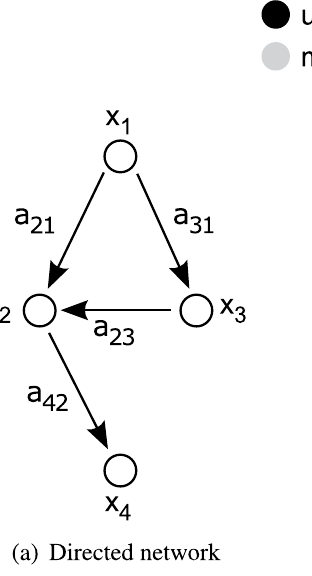
Figure 2. Maximum matching in directed networks. ( a ) Simple, unweighted directed graph with four nodes and four edges. ( b ) Result of maximum matching in the directed network. Edge a 21 cannot be a member of the disjoint set of edges, as it has a common starting point with a 31 and a common end point with a 23 . End points of matched edges are matched nodes. ( c ) Undirected representation of the directed network. For each node in the directed network there are two nodes in the undirected representation, one for outgoing edges and one for incoming edges. The representation of edges is obvious. The result of maximum matching is the same in both directed and undirected